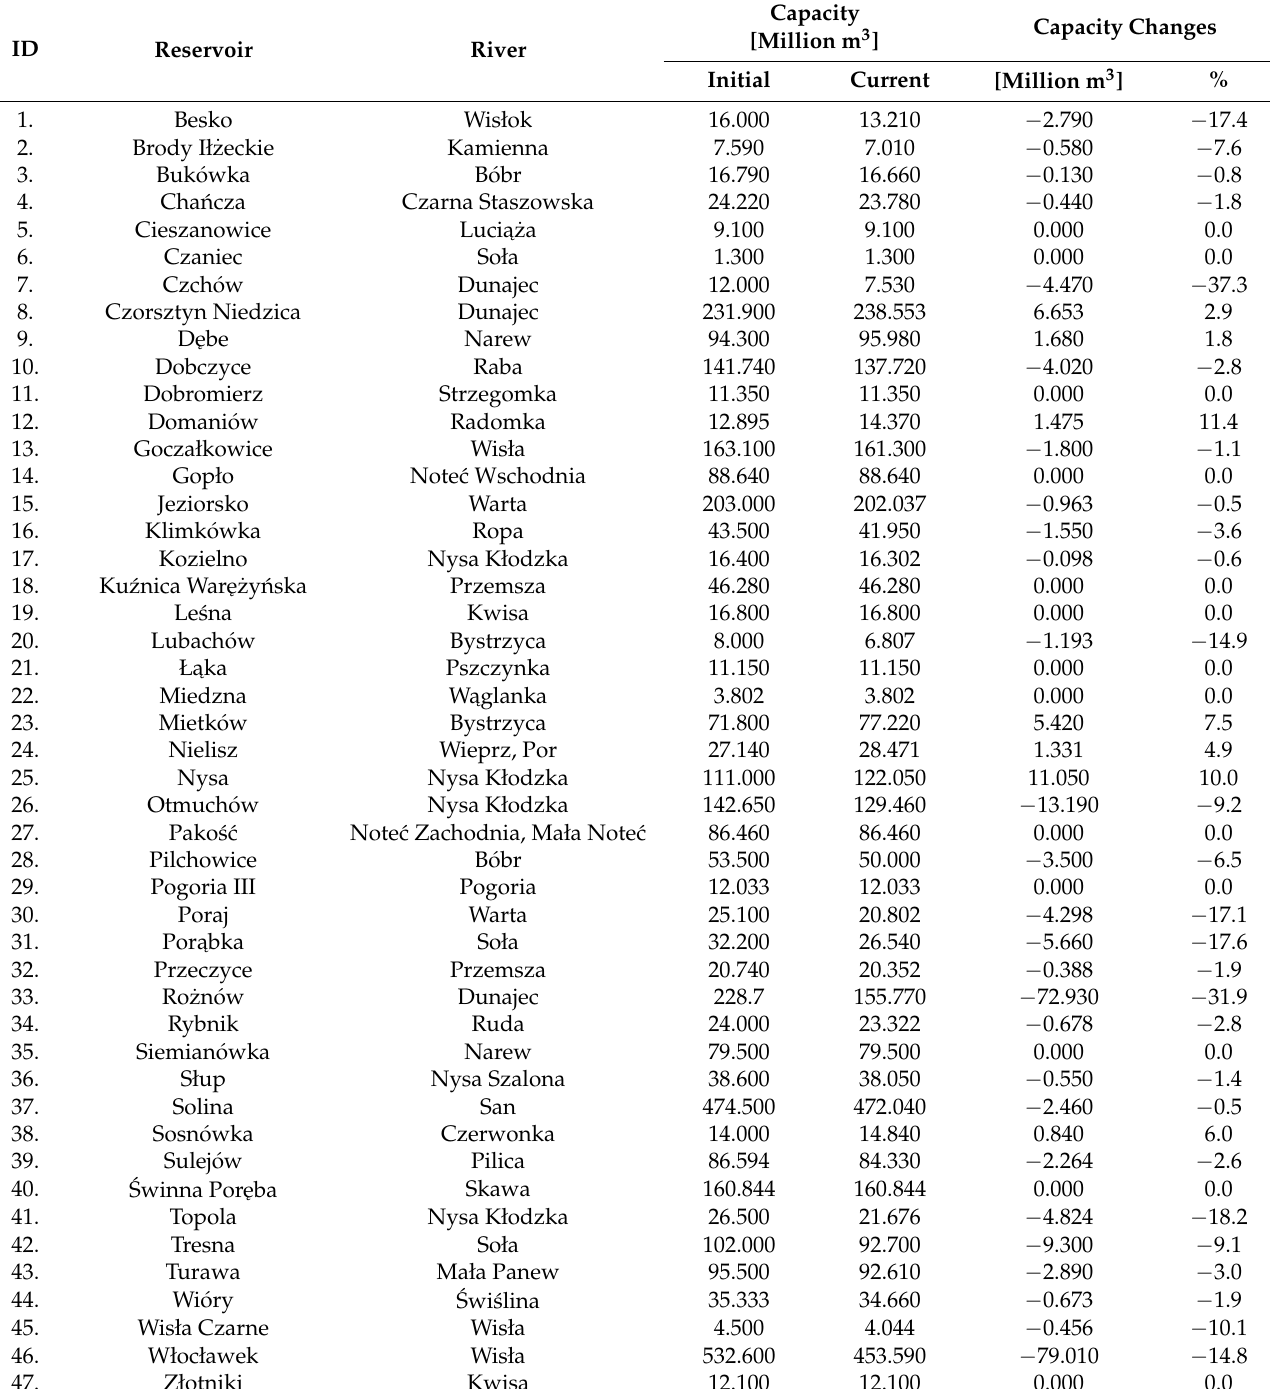
Table 1. Calculated changes in capacity at MaxDL in reservoirs of key importance for water management in